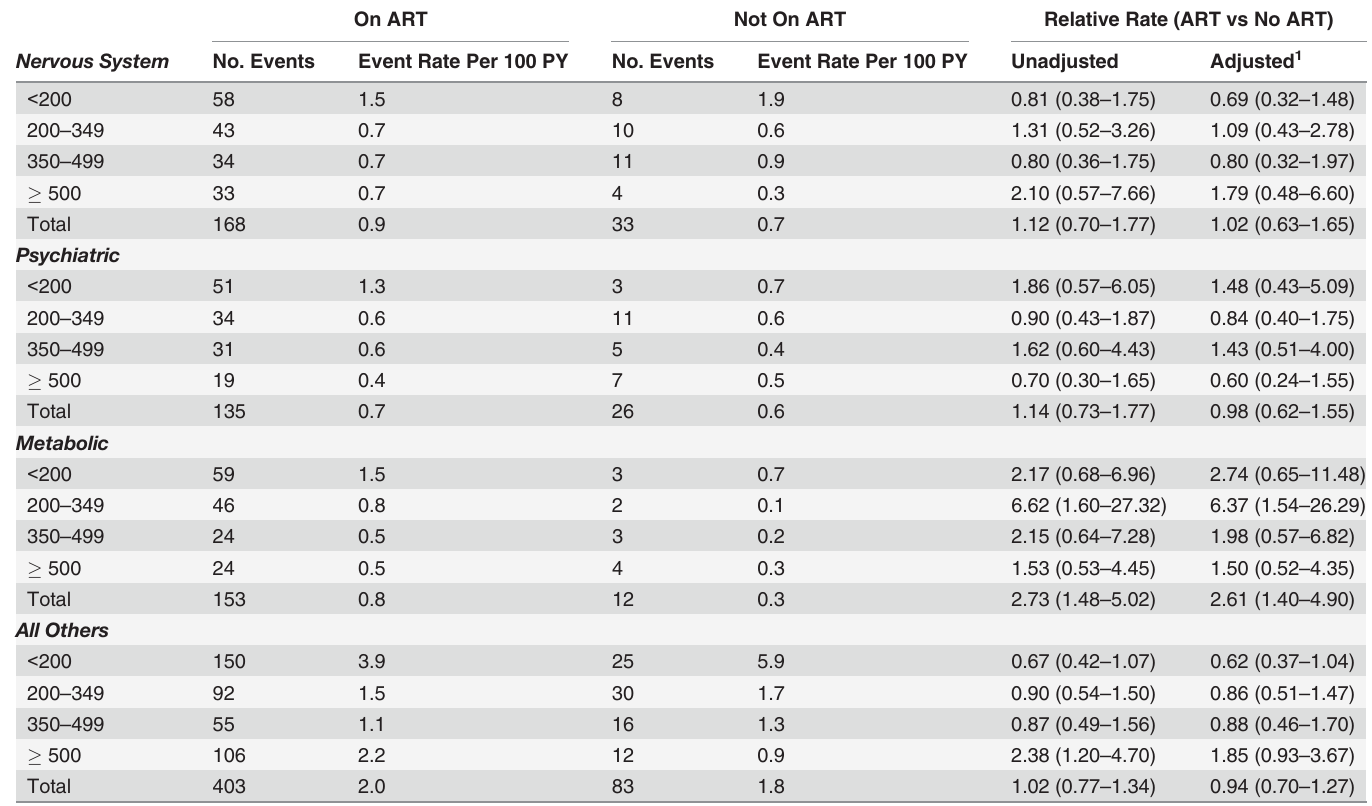
Table 7. Rates of Grade 4 Event Types by Latest CD4 Count (cells/mm 3 ) and ART Status: Morbidity and Mortality Cohort. On ART Not On ART Relative Rate (ART vs No